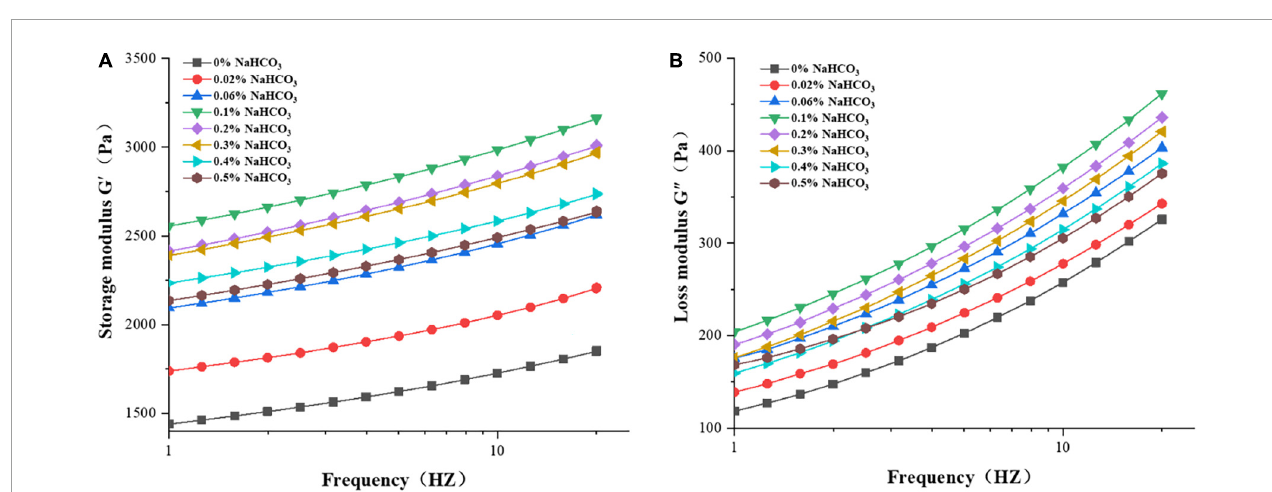
FIGURE2 Effect of sodium bicarbonate on storage modulus (A) and loss modulus (B) of rice flour.